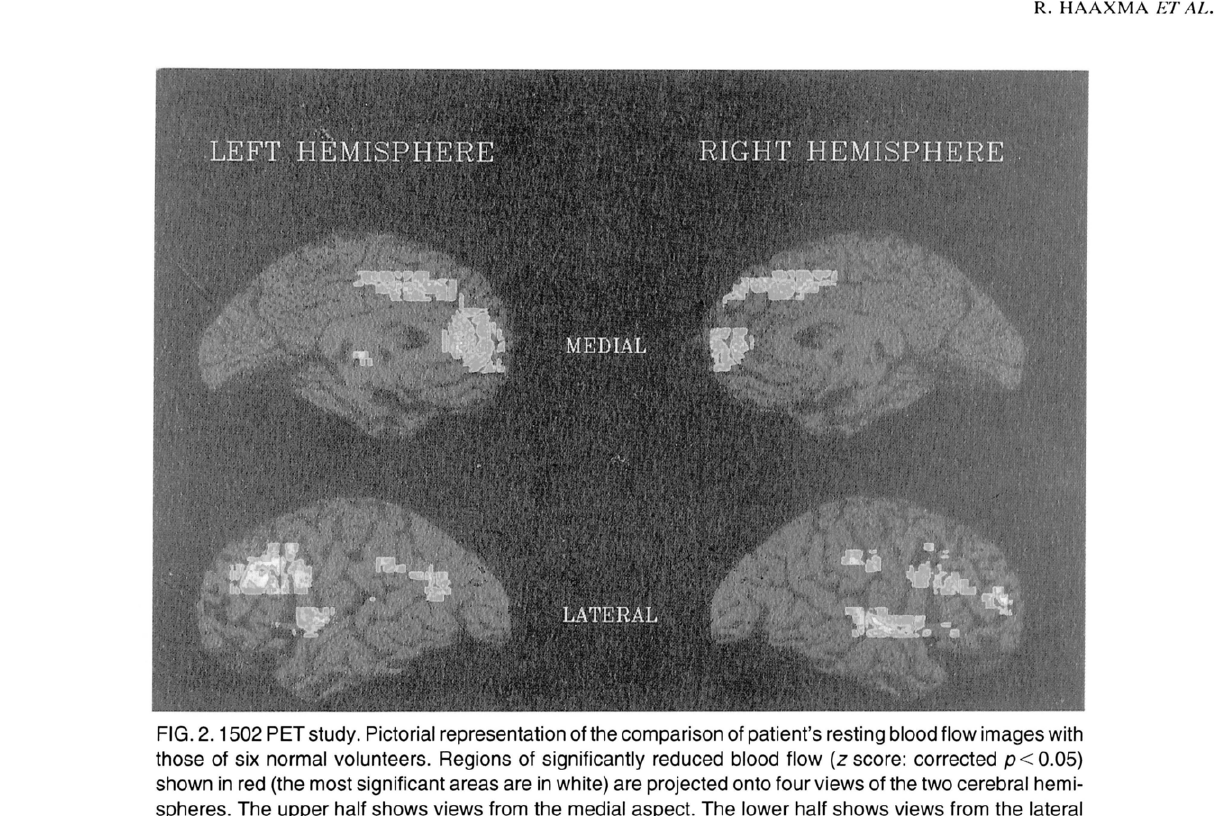
FIG. 2. 1502 PET study. Pictorial representation of the comparison of patient's resting blood flow images with those of six normal volunteers. Regions of significantly reduced blood flow (z score: corrected p < 0.05) shown in red (the most significant areas are in white) are projected onto four views of the two cerebral hemi spheres. The upper half shows views from the medial aspect. The lower half shows views from the lateral aspect. The areas of reduced flow were predominantly in the medial and dorso-Iateral parts of the frontal